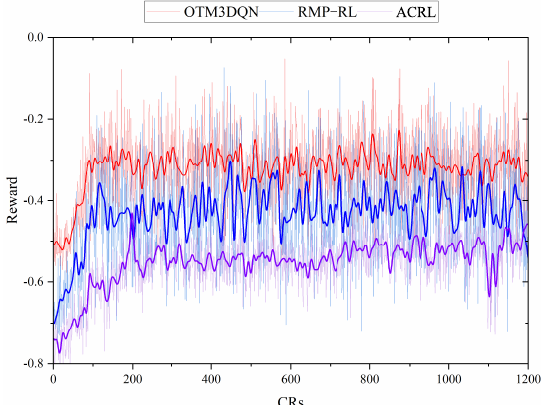
Figure 6. Training process average reward value for OTM3DQN, RMP-RL, and